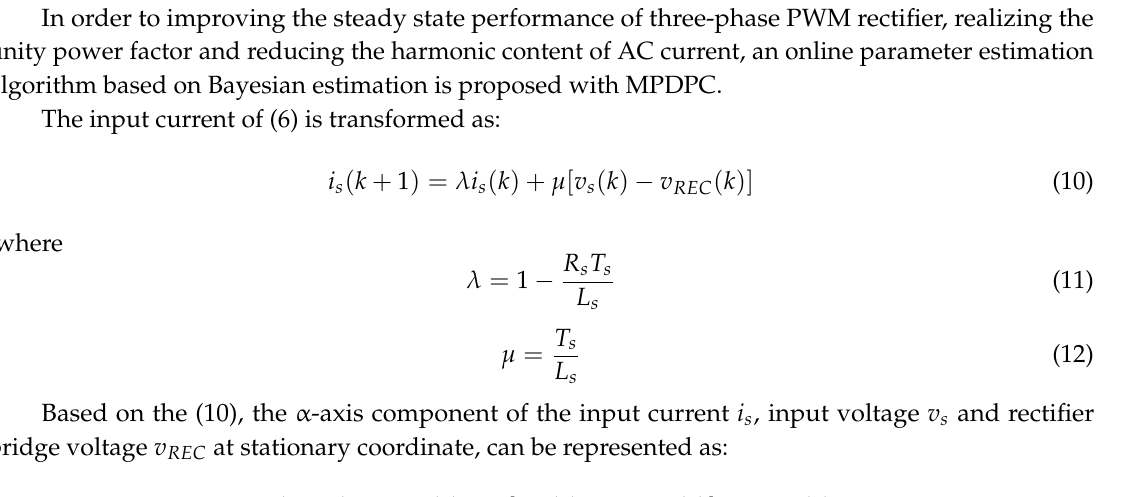
Figure 2. Power prediction under the influence of model parameter errors.